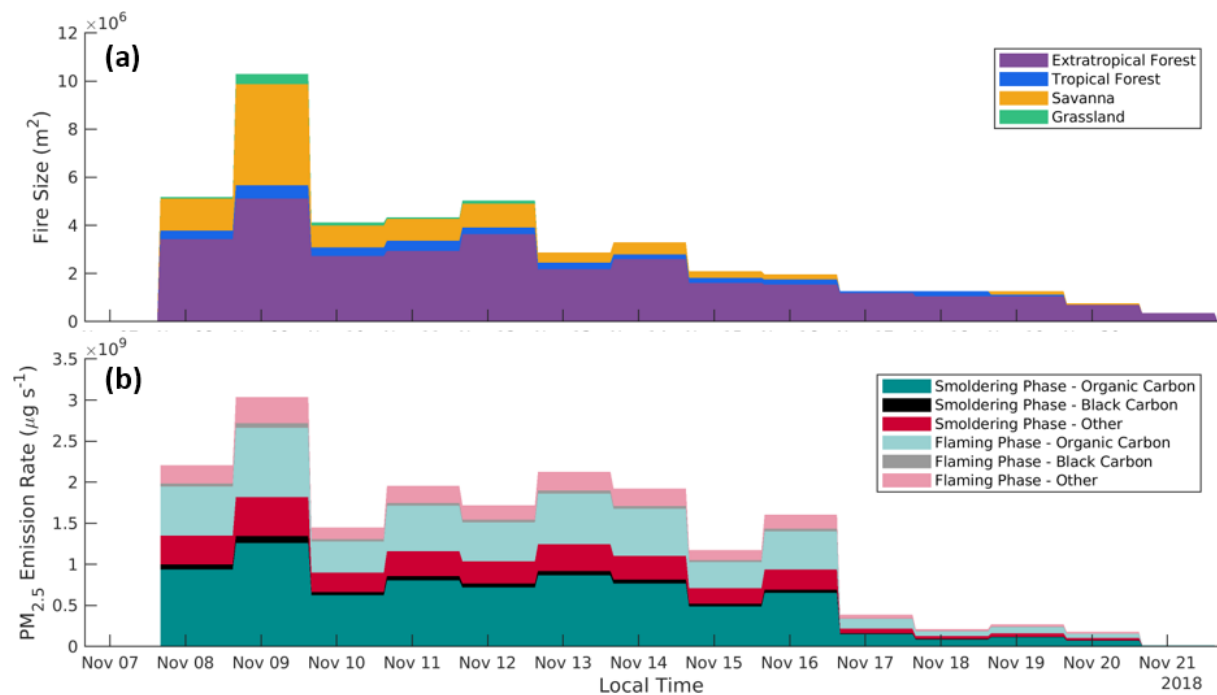
Figure 3. Wildfire area by vegetation type in m 2 (a) and PM 2 . 5 emission rate in µgs − 1 by combustion phase and species (b) input into WRF- Chem. The base inventory is produced from VIIRS and MODIS fire products using the PREP-CHEM-SRC processor and is employed by S_EMRAW. The control and remaining sensitivity simulations use an inventory with triple emission flux of all species on 13 November and double during 13–16 November, shown here. About 59% of total PM 2 . 5 emissions occur in the smoldering phase (darker colors in panel b ). The total PM 2 . 5 emitted is composed of 69.5% organic carbon and 4.5% black carbon. The Camp Fire burned primarily extratropical forest (purple) followed by savanna (yellow). Burning of extratropical forest generated the greatest fraction of emissions in the flaming phase at 44.2%, followed by savanna at 22.9% and tropical forest at 17.4%. Grassland emits only in the smoldering